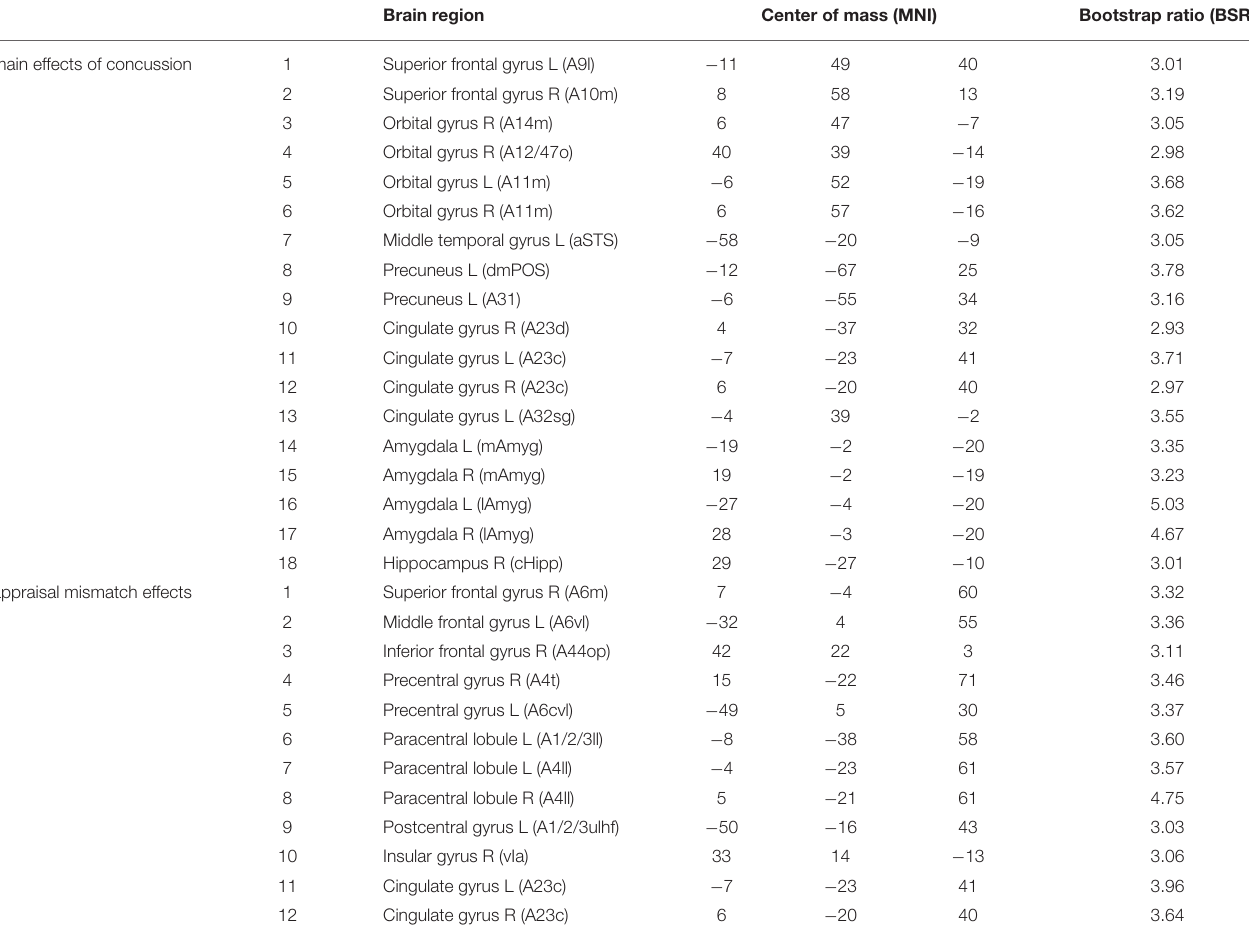
TABLE 2 | Brain regions with significant whole-brain salience effects, indicating a network of regions where insular connectivity is associated with main effects of concussion and the effects of appraisal mismatch; the identified regions correspond to the brain maps shown in Figures 1C , 2C , respectively. Brain region Center of mass (MNI) Bootstrap ratio